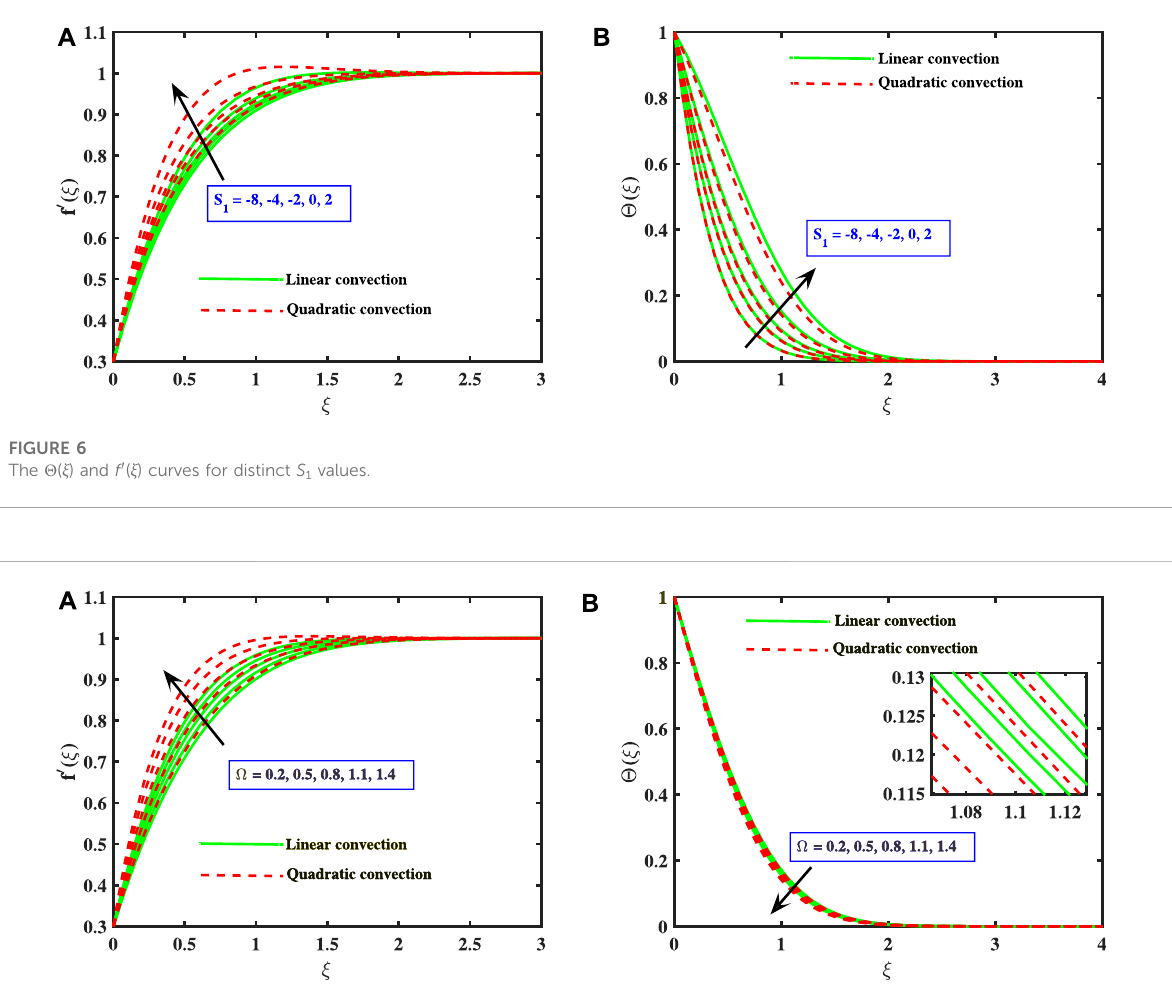
FIGURE 7 The Θ ( ξ ) and f ′ ( ξ ) curves for distinct Ω